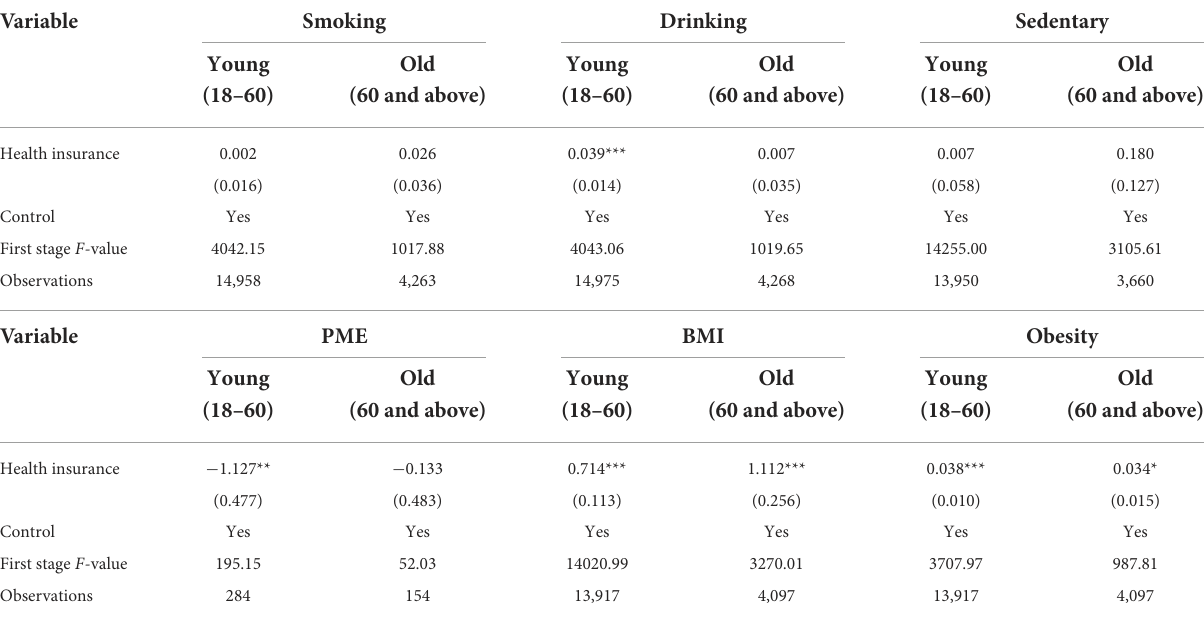
TABLE 6 Heterogeneity by age.